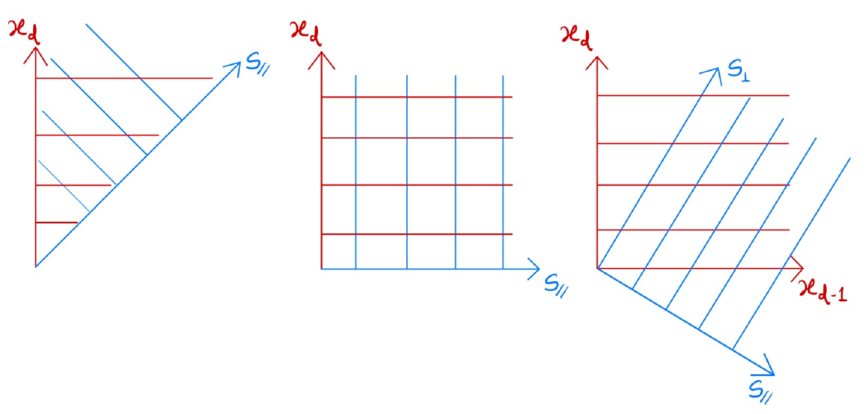
Figure 5 . Regions of convergence for each BOE. Coloured lines represent the region where the associated BOE converges. Lines intersect in the region of mutual